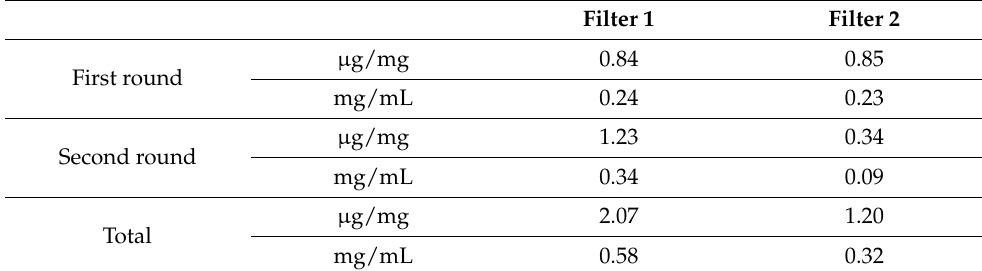
Table 1. Characteristics of protein binding to monolith filter.